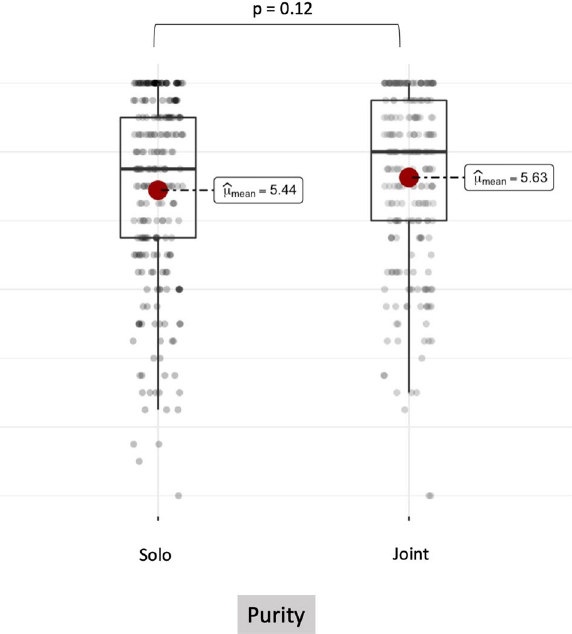
Figure 4. In the first blocks, participants punished individuals for Solo actions (dark grey) more than Joint actions (light grey) in Harm scenarios (left) but not in Purity conditions (right).